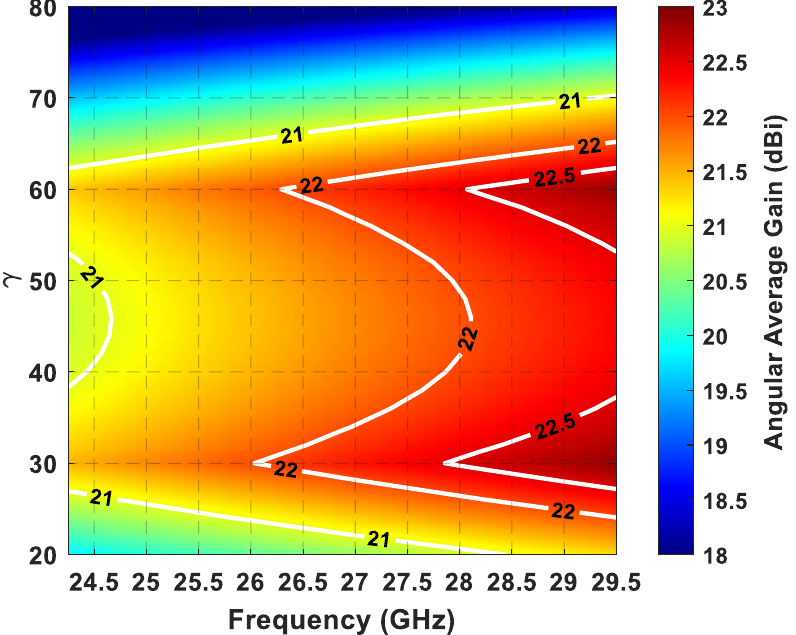
Figure 6. Angular average gain ( η Gain ) as a function of the γ value within the working frequencies (24.25 – 29.5 GHz) in the case of a triangular lattice planar array of 8 × 8 elements. In view of highlighting the impact of the antenna array lattice, two 8 × 8 planar arrays were considered—the former with elements arranged on a square lattice, and the latter on an equilateral triangular ( γ = 60 ◦ ) grid. It is worth noting that, as stated before, in a triangular lattice placement of the elements there are two most suitable values, namely, γ = 30 ◦ and γ = 60 ◦ . However, in the following performance comparison, it was decided to use an equilateral triangular lattice due to its more uniform footprint in the u–v plane, as shown in Figure 5b. By considering the Equations (3)–(5), with R = 1.1, for a square lattice d 0 turns out to be 5.17 mm (0.508 λ HF ), whereas the equilateral triangular grid exhibits a minimum element distance of 5.97 mm (0.587 λ HF ), hence offering a 13.5% improvement. It is worth observing that values of R greater than 1 assure the absence of grating lobes during the beam steering inside the circular sector [43]. The same R value for both lattices provides the same distance in the u–v plane between the closest grating lobes and the center of the visible region ( u = 0, v = 0), and hence, the same PSLL value as a function of the beam steering inside the circular sector cell. Furthermore, PSLL is around –13.3 dB at the broadside, whereas with the increase in the θ steering angle, PSLL degrades up to around –9 dB for θ = 60 ◦ due to the cosine-shaped elements’ radiation pattern. The larger minimum distance obtained via a triangular lattice arrangement allows us to achieve a lower level of mutual coupling among antenna elements by ensuring greater robustness of the active impedance of the array elements along the beam steering, a superior linearity of the employed power amplifiers (PAs), and a general improvement of the massive MIMO performance [41]. The wider element distance offered by the triangular lattice can be also considered advantageous for the thermal aspect, by helping the cooling system of the transceiver, which is critical in large mm-wave phased arrays [31]. The overlapped array geometry of triangular and square lattices is illustrated in Figure